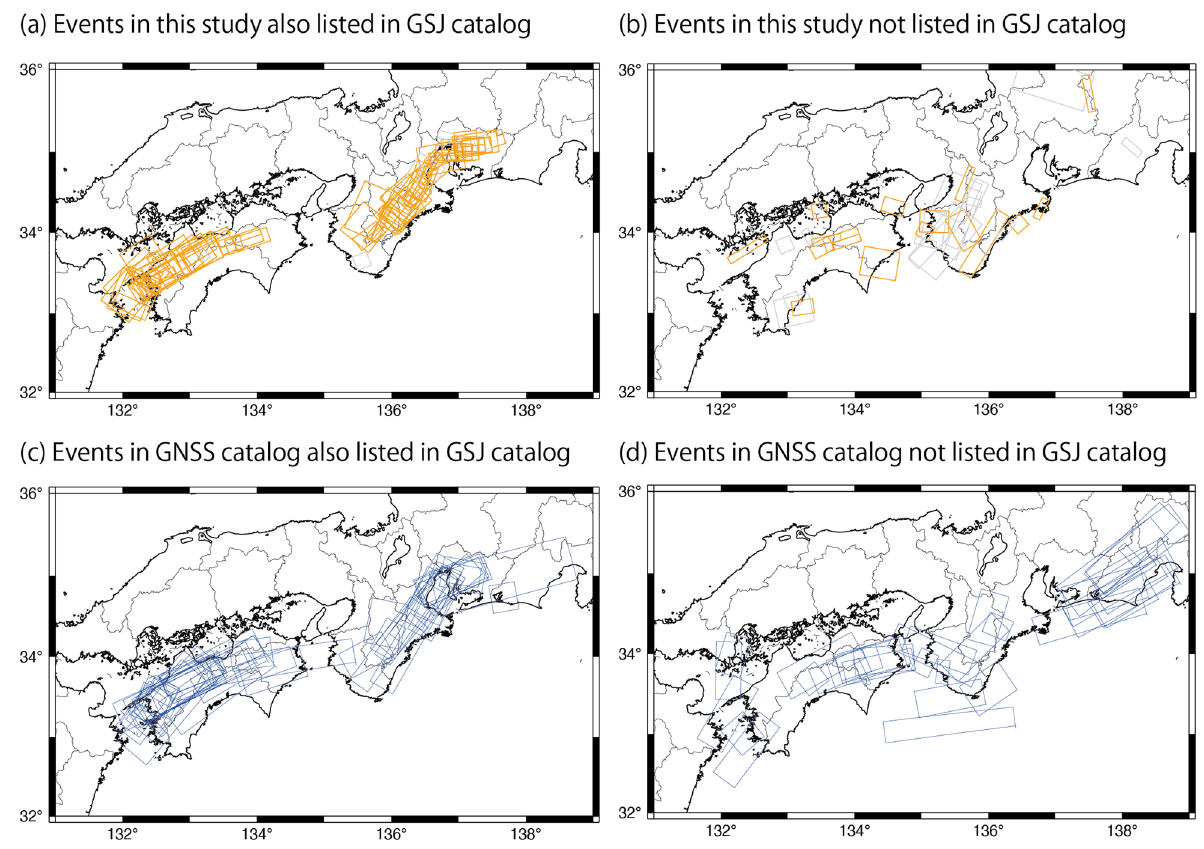
Fig. 10 Spatial distributions of fault models of events in the catalogs of this study and GNSS. a Fault models of events in the catalogs of this study and GSJ. b Fault models of events in this study’s catalog, but not listed in the GSJ catalog. c Fault models of events in the GNSS and GSJ catalogs. d Fault models for events in the GNSS catalog, but not in the GSJ catalog